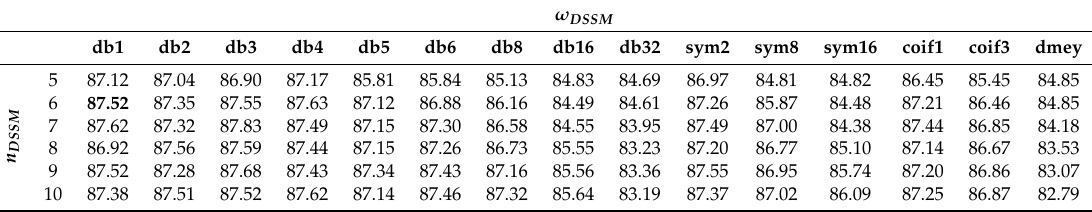
Table 12. The accuracy (%) of three class sleep stage classification with different wavelet bases and different order of DSSM under AASM standard. Only DSSMFs are used, no